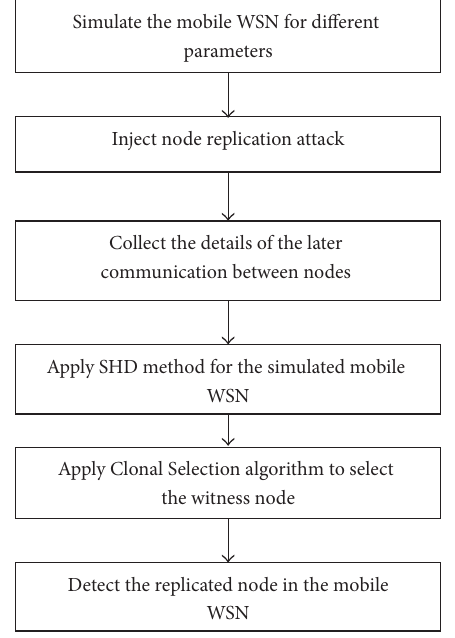
Figure 1: Flow diagram of the proposed